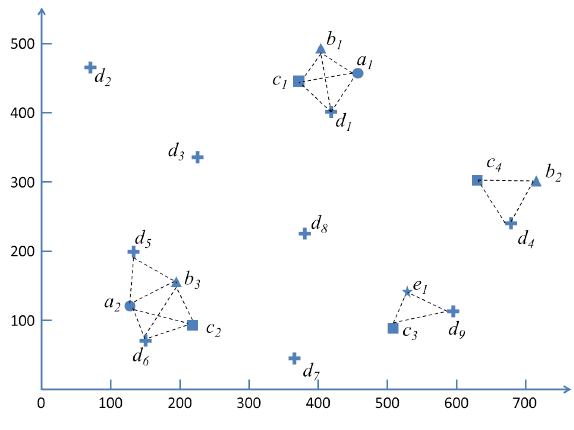
Figure 2. The neighbourhood